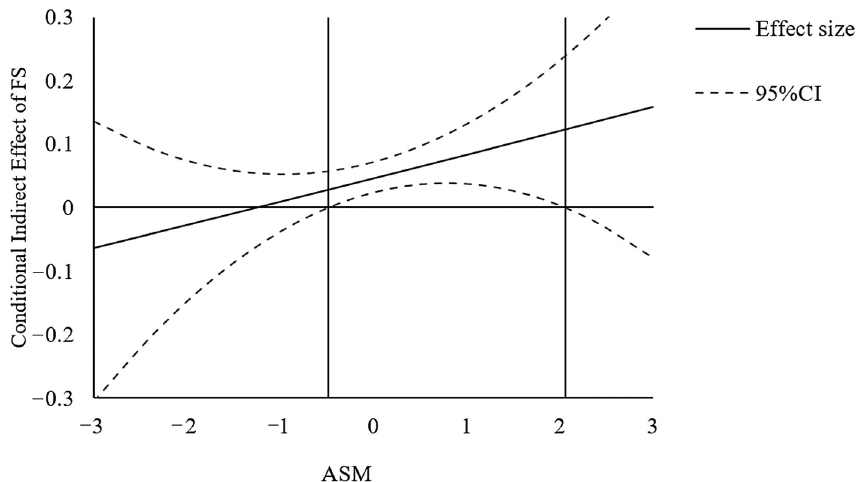
Figure 4. The indirect effect of Income on Emotional Well-being (EWB) via Financial Satisfaction (FS) versus Ability to Savor the Moment (ASM), with confidence bands in study 2.